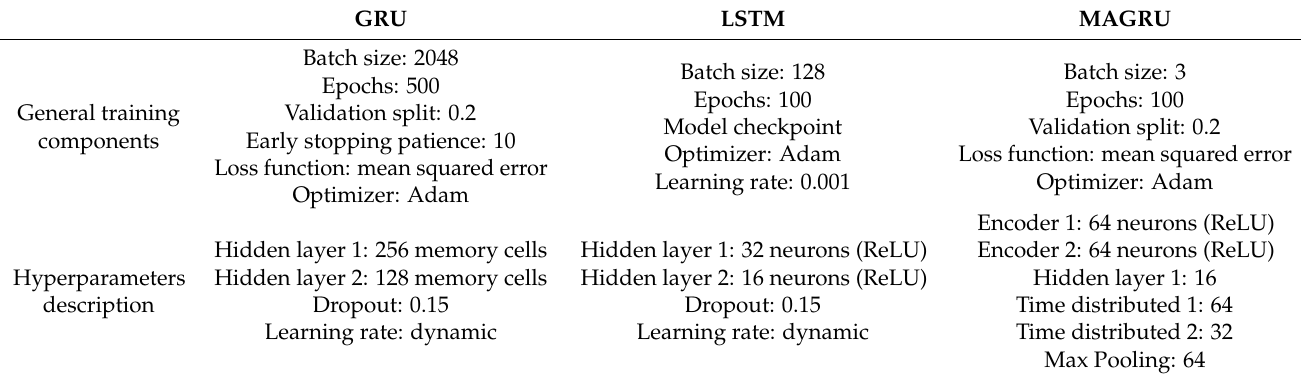
Table 2. Description of the structures of the different DL models for TN prediction.